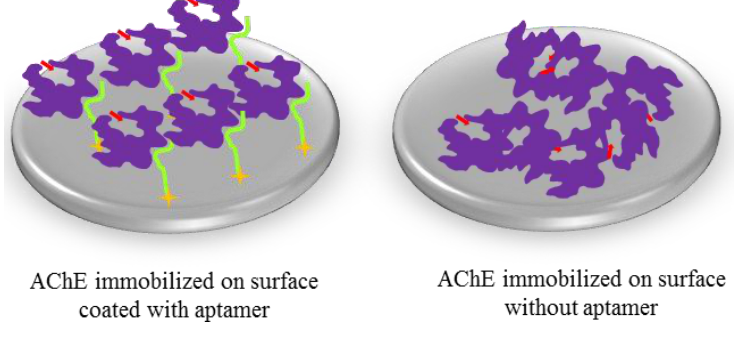
Figure 1. Site-directed immobilization of AChE mediated through aptamer binding versus adsorption of AChE to a polystyrene microtiter plate. The former allows specific orientation and well-controlled immobilization of AChE whilst the latter results in AChE immobilized in random orientations. The purple represents unmodified AChE molecules whilst the light green indicates the AChE-binding aptamer and the gold stars show the attachment chemistry of the aptamer molecules to the surface. The red arrows show AChE’s substrate channel. In our experiment, the aptamer was immobilized on a streptavidin-coated surface through biotin at its 5′- or 3′-end. Biotin incorporation is straightforward to implement during the synthesis of the aptamer. Alternatively the aptamer can be attached to gold surfaces through a 5′- or 3′-thiol end, a method particularly well suited to sensing applications.